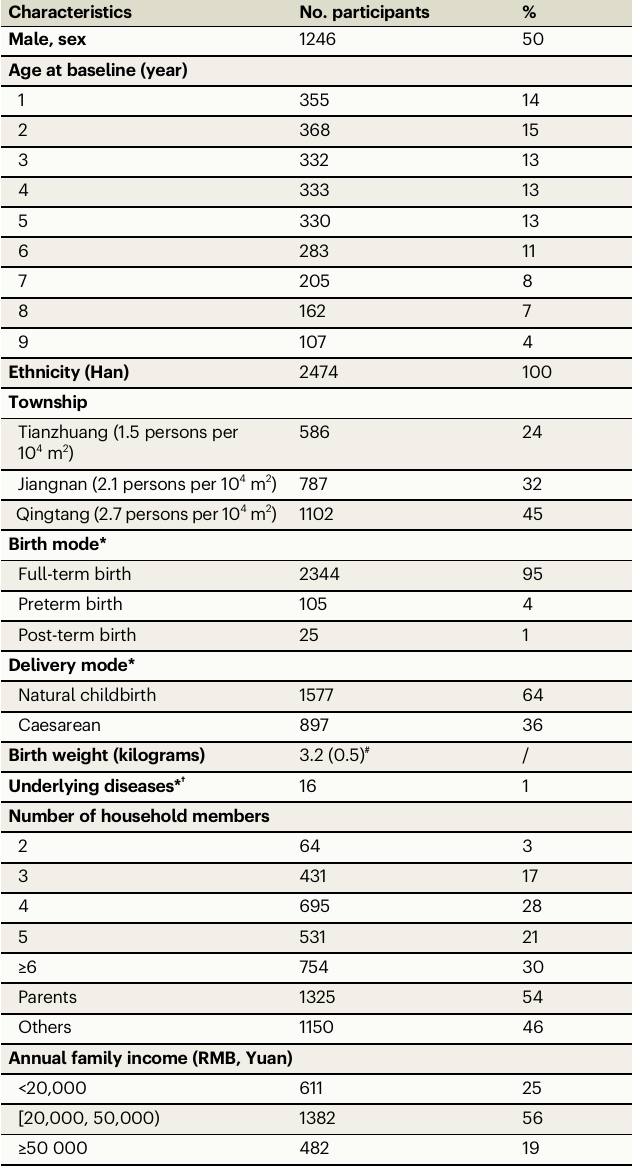
Table 1 | Characteristics of participants with lab test results ( n = 2475) being performed at recruitment in Children cohort